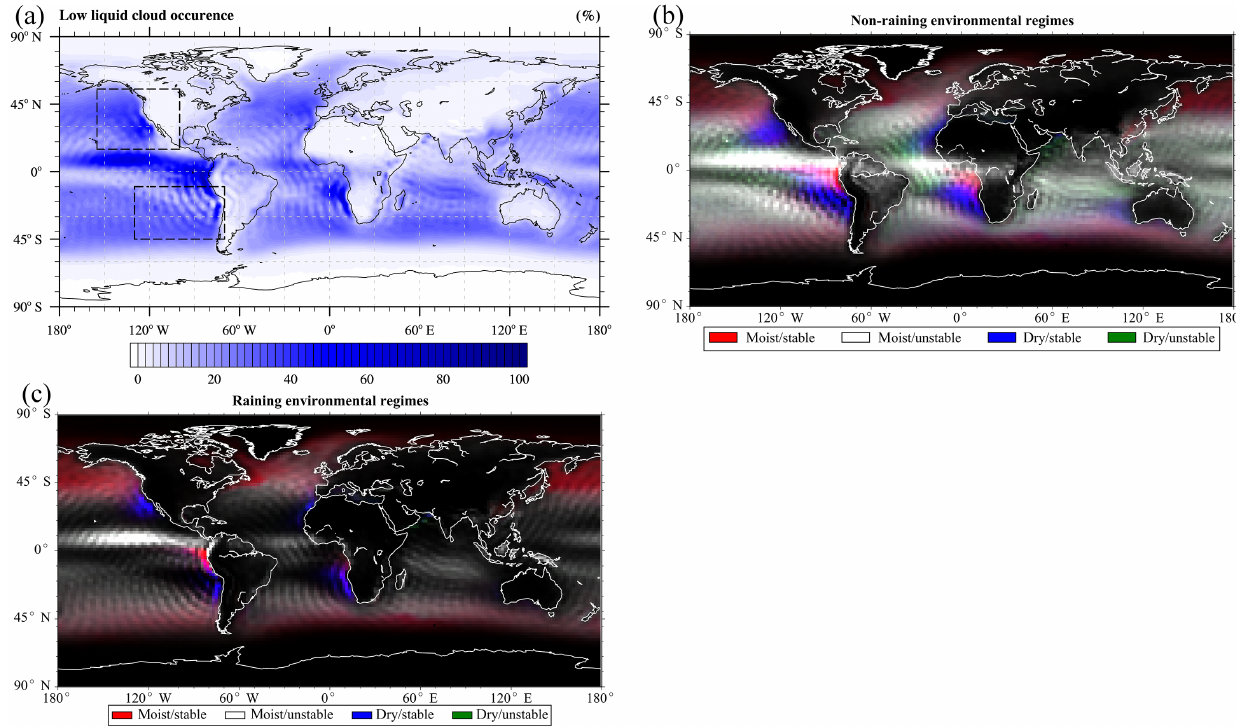
Figure 1. Average frequency of the occurrence of low liquid clouds (cloud-top pressure >500hPa, cloud-top temperature >273.15K) in E6_Ref between 1995 and 2012 in (a) for all environmental regimes together, (b) for non-raining regimes, (c) for raining regimes. In (a) are also the two stratocumulus regions where the impact of the analysed regions is